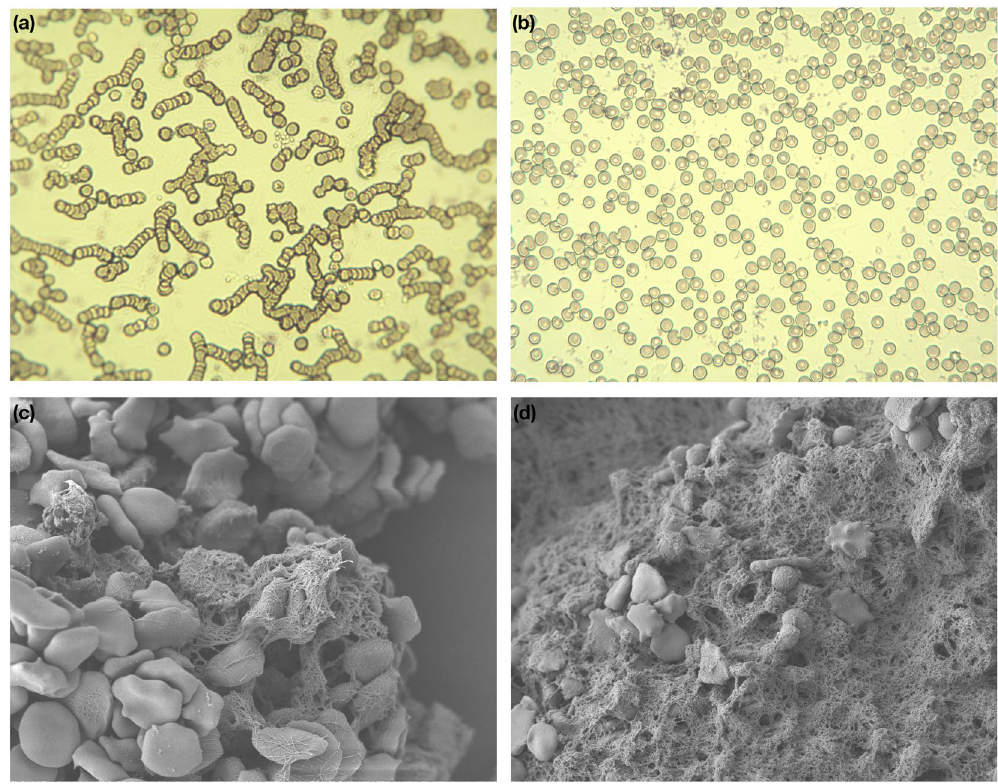
Figure 2. Equine blood microscopic images ( a ) showing aggregation of cells (coin-shape rouleaux formation) after samples were left to settle in the reservoir (magnification x400); ( b ) Sample images after pumping at varied shear rates (magnification x400); ( c ) Scanning Electronic Microscopic (SEM) images of a whole equine blood sample after two mins and; ( d ) SEM of whole equine blood sample after 20 mins of thromboplastin activation (magnification x5000), clearly showing erythrocytes and the development of Fibrinous Matrix